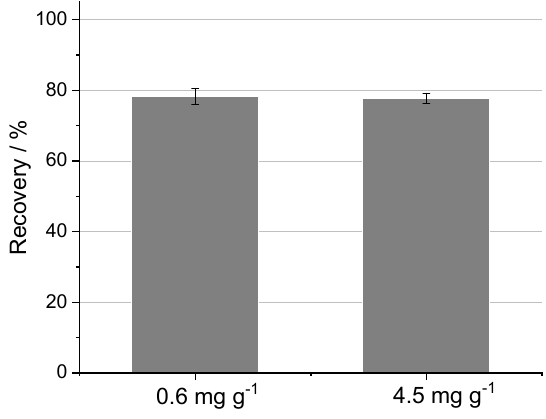
Figure 3. Recovery rates at low (0.6 mg g − 1 ) and high (4.5 mg g − 1 ) concentration.